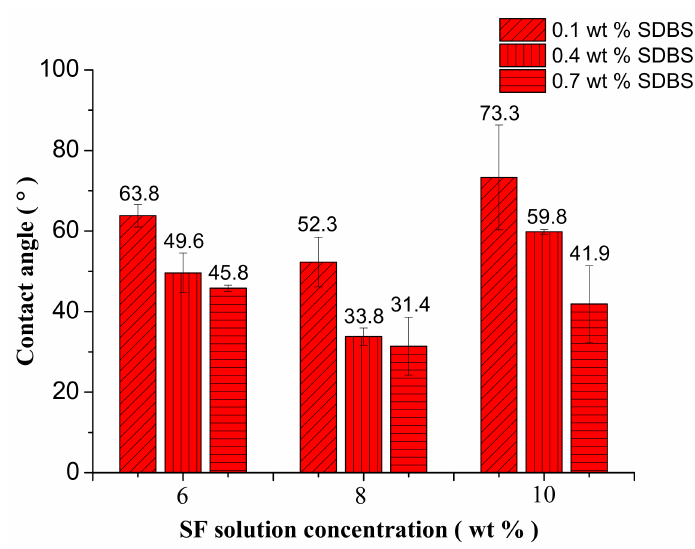
Figure 11. Contact angles of NFMs with the different SF concentrations and SDBS contents when the gas flow volume was 50 m 3 /h.